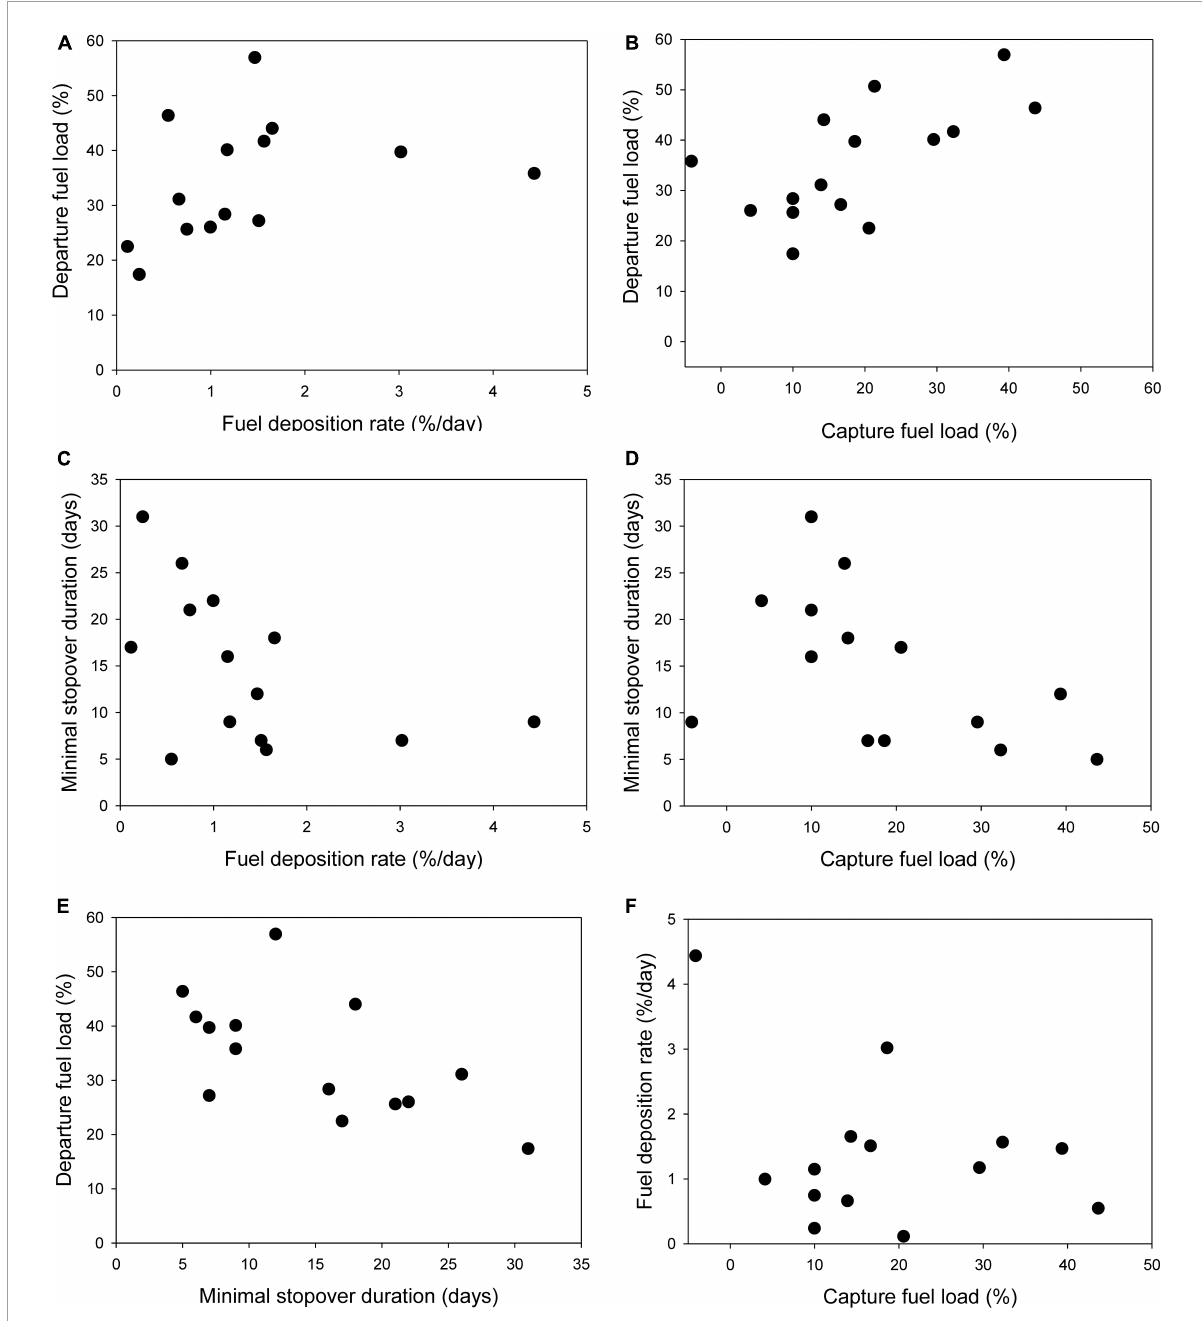
FIGURE2 The relationships between different stopover parameters of autumn migrating Red-backed Shrikes at the Hula Valley, Israel. (A) Fuel deposition rate and departure fuel load. (B) Capture fuel load and departure fuel load. (C) Fuel deposition rate minimal and stopover duration. (D) Capture fuel load and minimal stopover duration. (E) Minimal stopover duration and departure fuel load. (F) Capture fuel load and fuel deposition